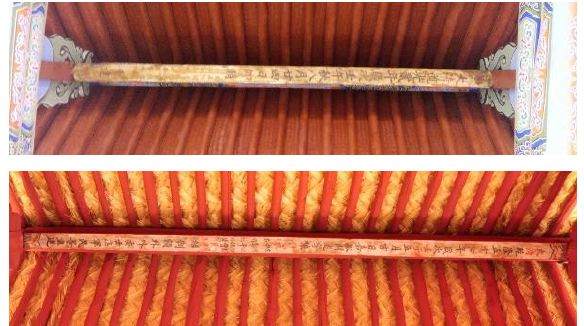
Figure.10 inscribed verbal contents under the ridge purlin in Wenchang pavilion and Stage